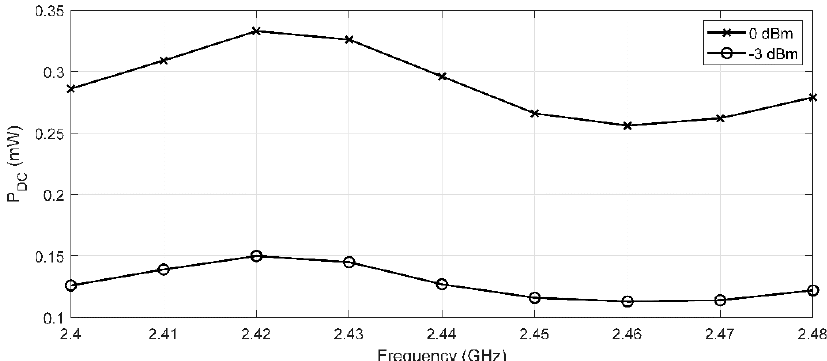
Figure 8. Textile rectifier output DC power P DC vs. Frequency.